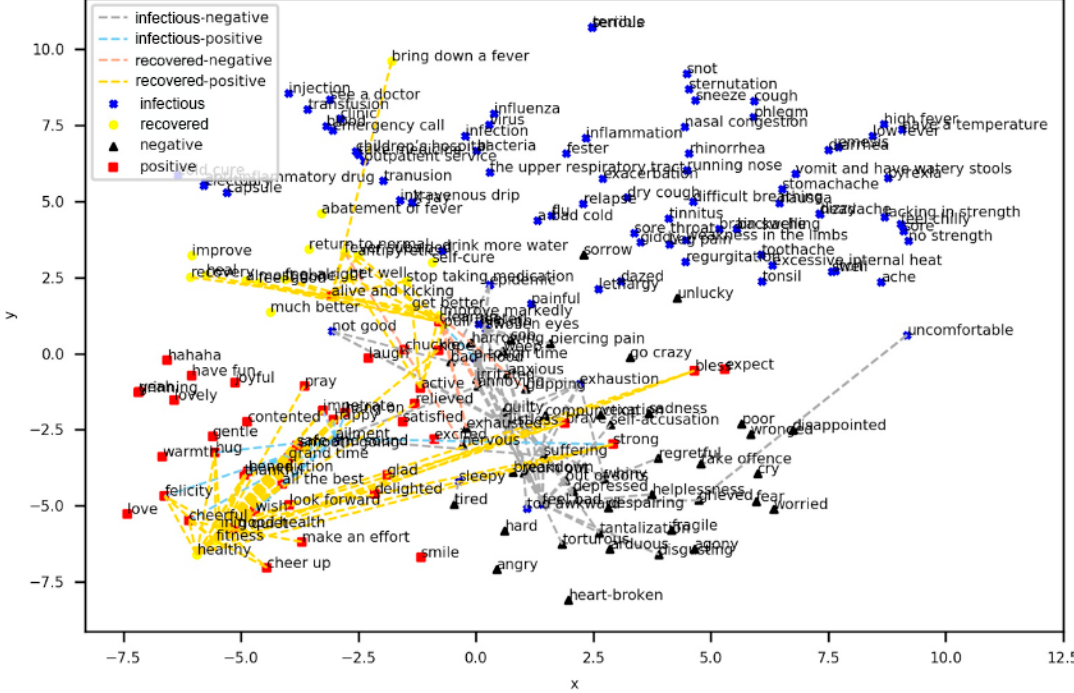
Figure 10. Two-dimensional Word Embedding Scatter Plot.